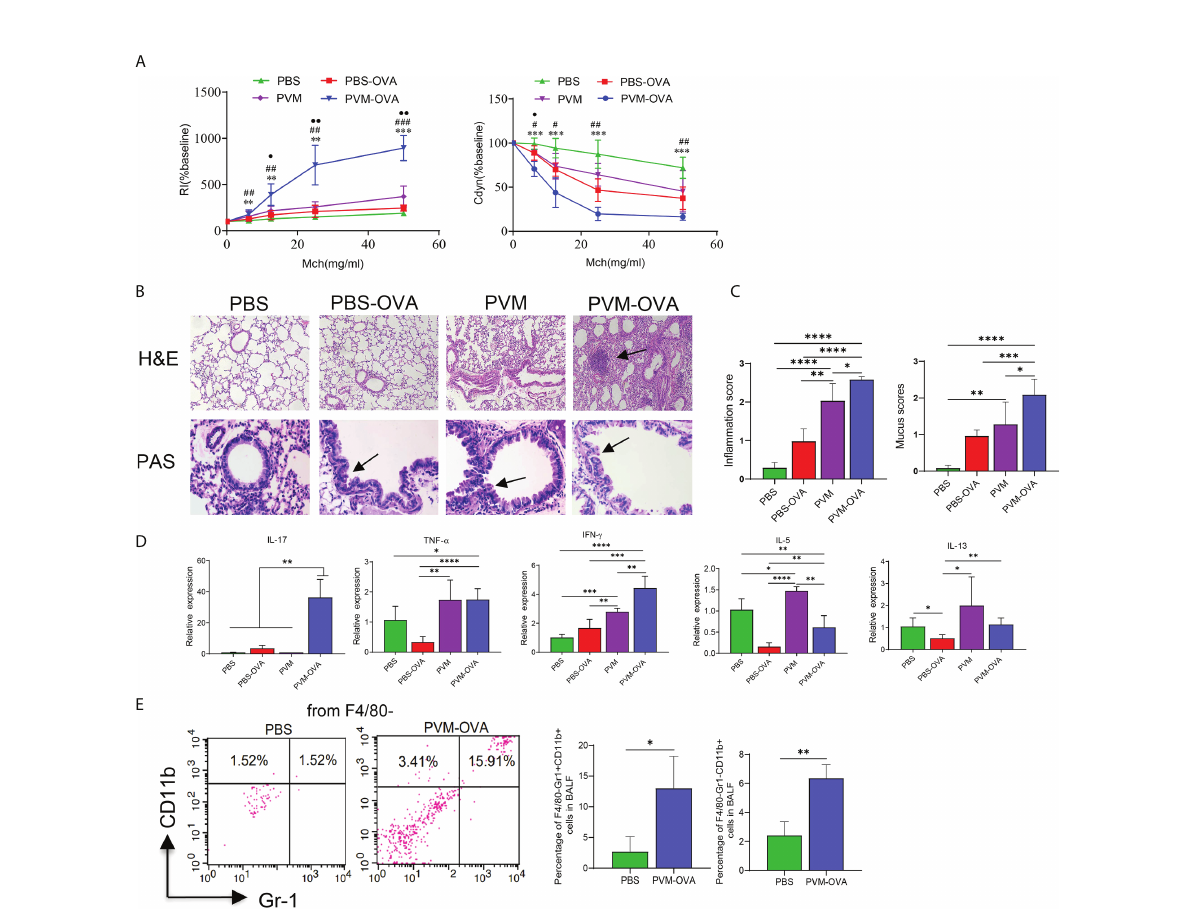
FIGURE 1 Neonatal PVM infection combined with OVA sensitization facilitated childhood allergic asthma in mice. (A) Airway resistance index (RI) and lung dynamic compliance (Cdyn) to increasing doses of inhaled methacholine (MCh, 6.25, 12.5, 25, and 50 mg/ml) following OVA challenge from day 21 to 25 post infection in mice. PVM-OVA group compared with PBS group, *, with PBS-OVA group, #, with PVM group, ● . (B) H&E staining shows peribronchiolar, perivascular, and interstitial in fl ammatory cell in fi ltration (100X). PAS staining shows bronchiolar mucus production (400X). (C) Scores for pulmonary in fl ammation and mucus. (D) Relative expression of cytokines in lung tissue by real-time PCR. (E) Expression of CD11b and/or Gr-1 on F4/80 — BALF cells in PBS and PVM-OVA group by fl ow cytometry. Each experimental group contained three biology repeats. Data are presented as means standard deviations of 5-6 mice per group and are representative of two experiments. Values are shown as means ± SEM. (*P<0.05, **P<0.01, ***P<0.001, ****P<0.0001 ## P<0.01, ### P<0.001, (cid:129) P<0.05, (cid:129)(cid:129)